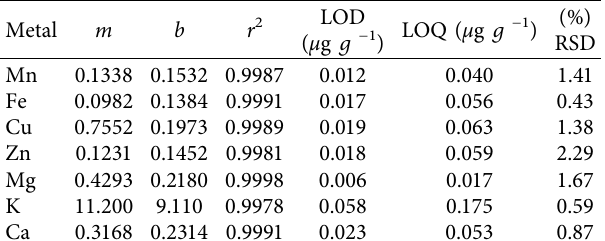
Figure 2: Vortexing time and temperature influence on micro- and macroelements recovery from SRM (NIST 1515). Table 7: Parameters of the calibration curve, results of detection limits, and precision